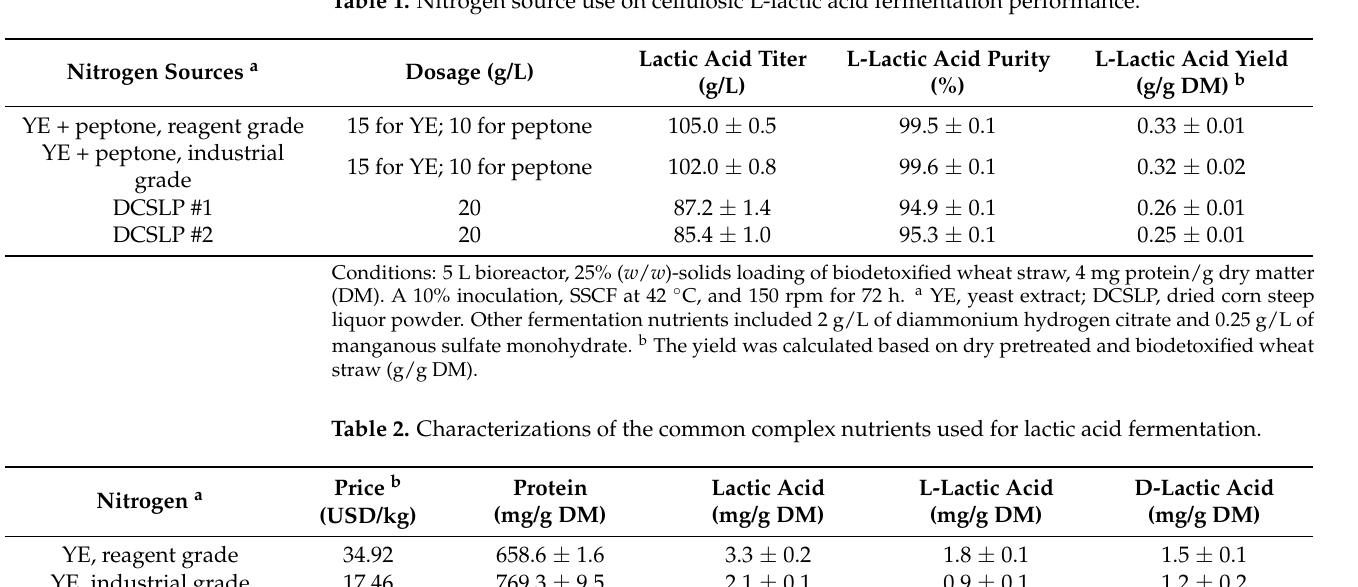
Table 1. Nitrogen source use on cellulosic L-lactic acid fermentation performance.